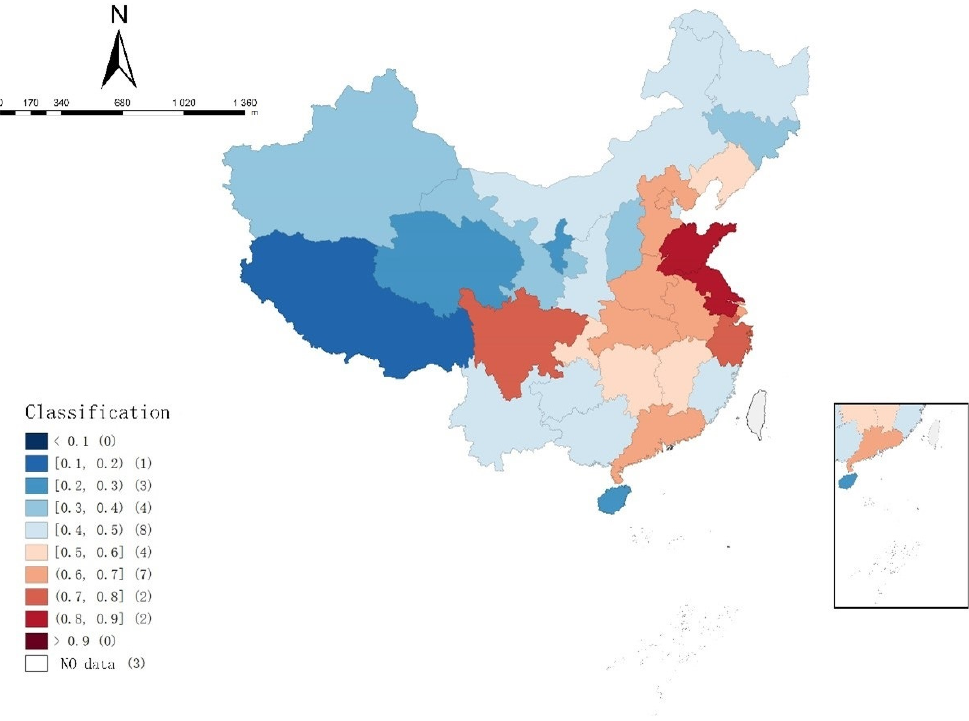
Figure 3. The spatial distribution of the coupling coordination degree of 31 regions (2010 to 2019).